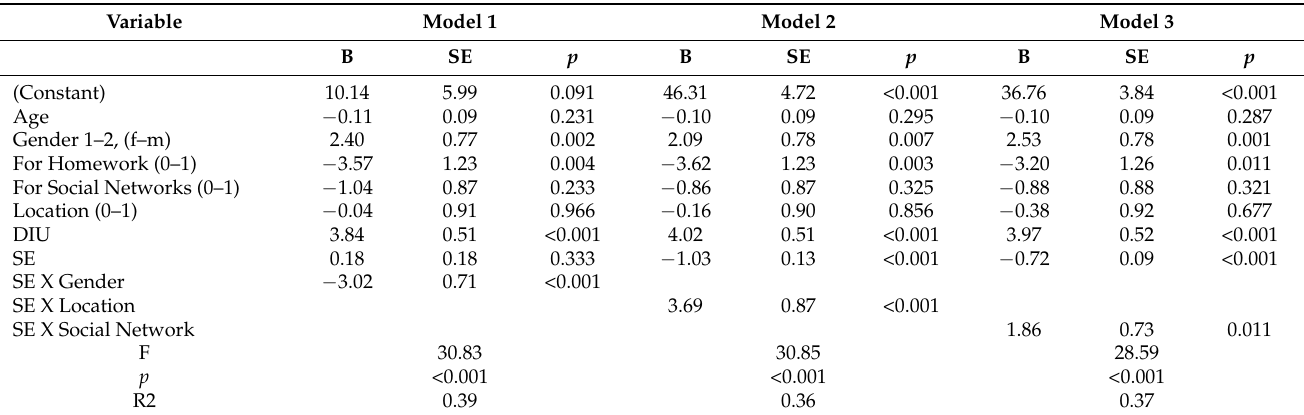
Table 5. Direct interaction effects on internet addiction.